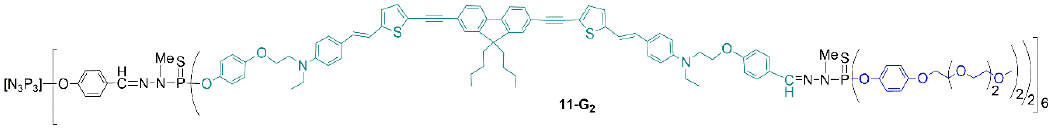
Figure 15. Fluorescent phosphorhydrazone dendrimer potentially useful for photodynamic therapy under two-photon irradiation.